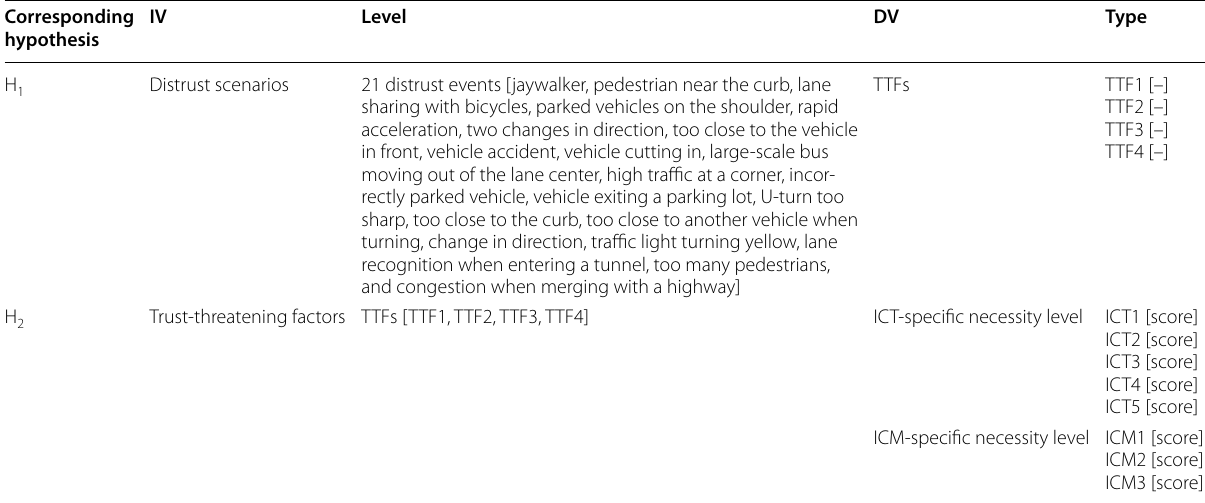
Table 2 Description of independent variables (IVs) and dependent variables (DVs) Corresponding